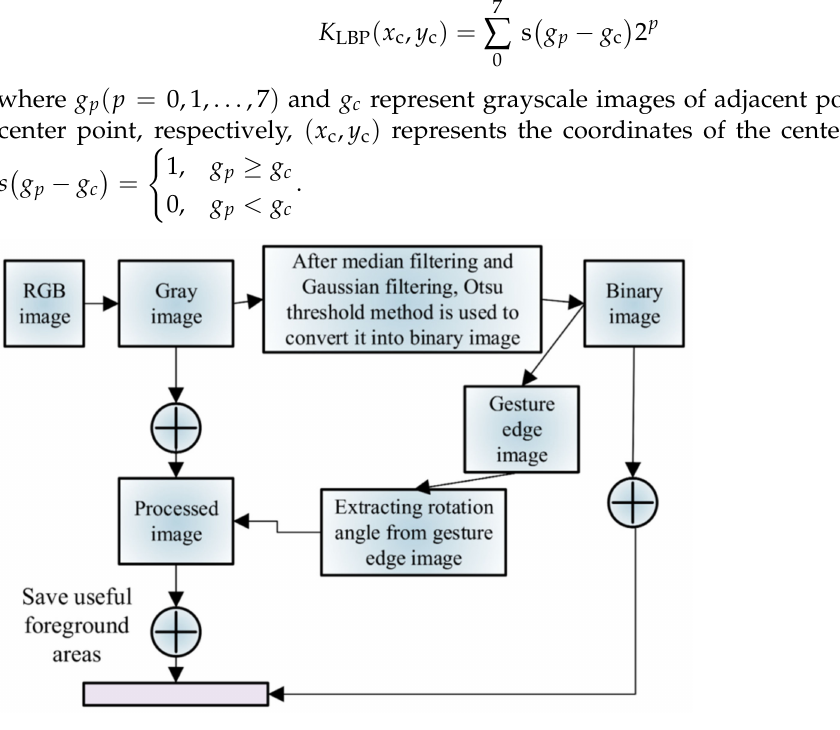
Figure 2. Preprocessing of gesture